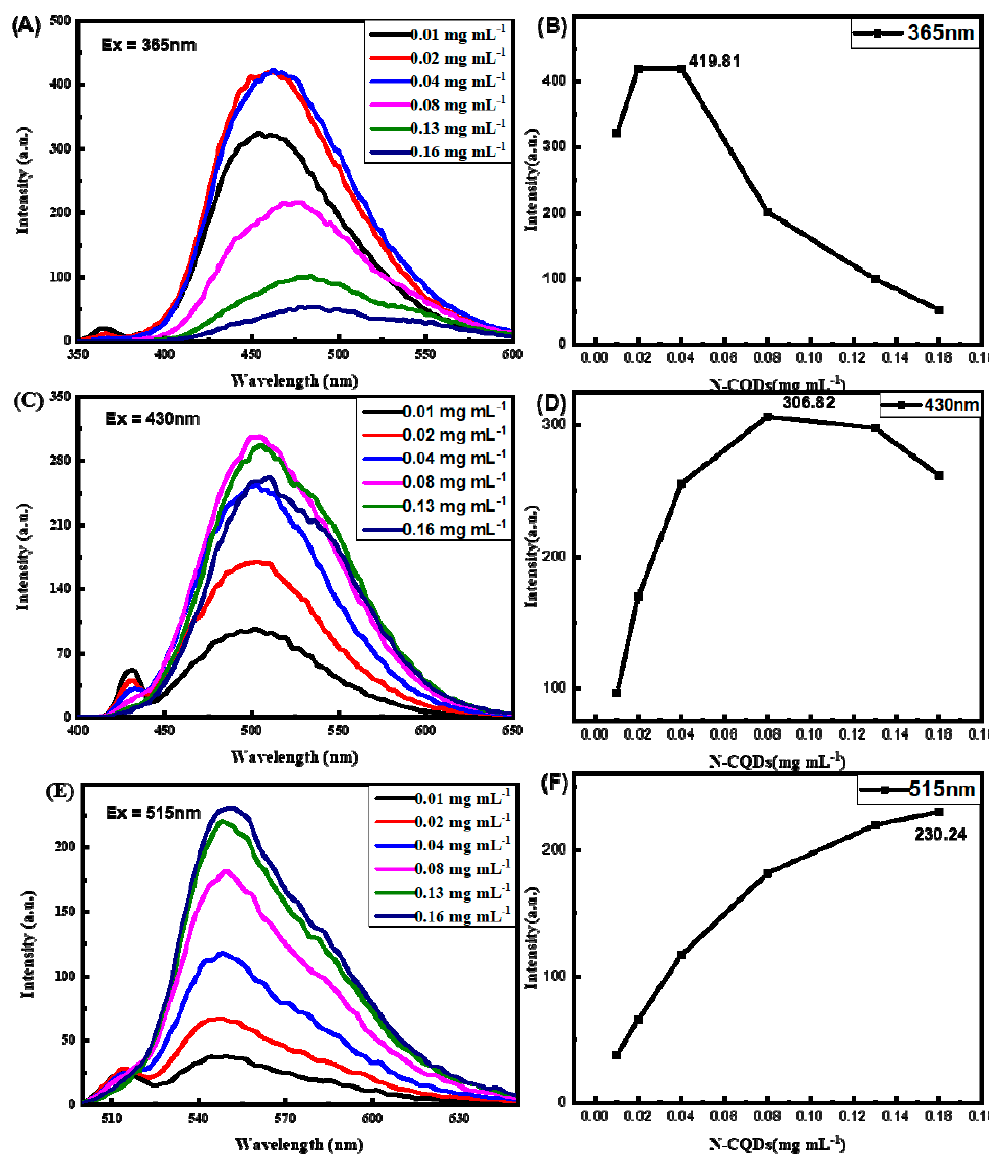
Figure 3. ( A , C , E ) Emission spectra excited with 365 nm, 430 nm and 515 nm light as a function of N-CQDs concentration, respectively and ( B , D , F ) fluorescence intensity of N-CQDs with different excitation wavelengths at 365 nm, 430 nm and 515 nm, respectively.